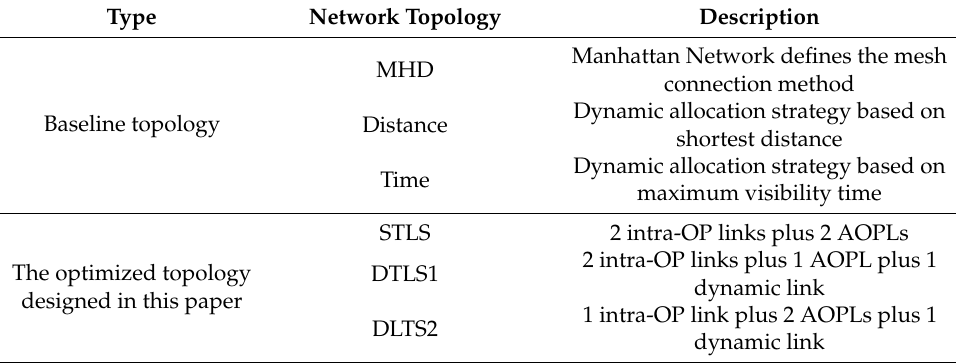
Table 3. Topology classification and description.